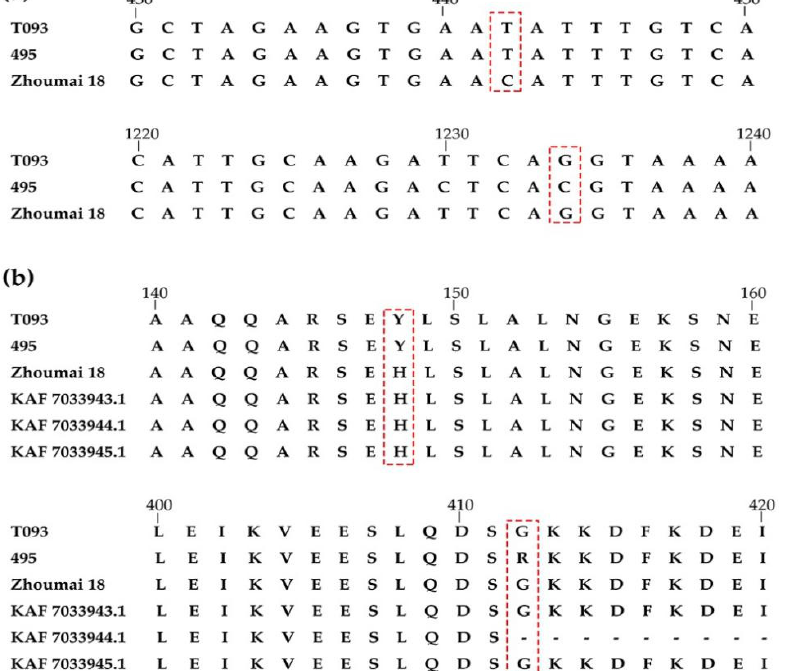
Figure 5. Analysis of TraesCS3D01G466100 cDNA and alignment of protein sequences. ( a ) The TraesCS3D01G466100 cDNA structure and variations among the alleles from T093, line 495, and Zhoumai 18. The bases in virtual frames result in the change of amino acids in predicting protein sequence in T093, line 495, and Zhoumai 18. ( b ) Alignment of protein sequences among homologous TraesCS3D01G466100 from T093, line 495, and Zhoumai 18, and three other Triticum aestivum (KAF7033943.1, KAF7033944.1, and KAF7033945.1) . The amino acids in virtual frames indicate the variation among line 495 and T093, Zhoumai 18, and three other Triticum aestivum .